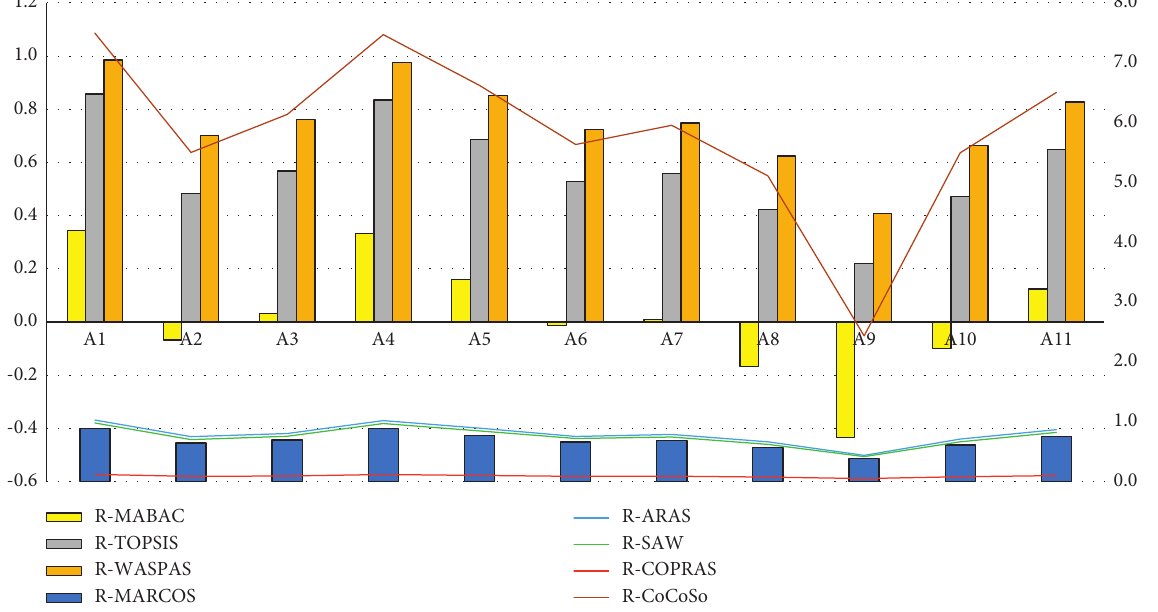
Figure 7: Alternative values in comparative Rough MCDM